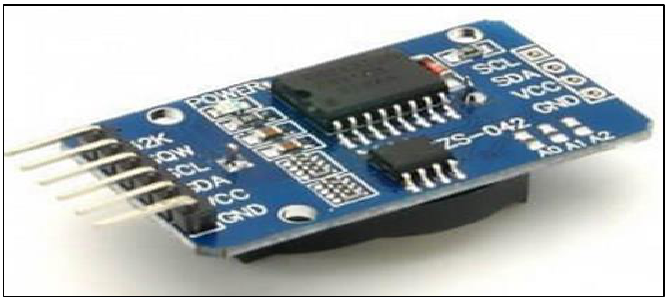
Figure 7: RTC to Raspberry Pi.